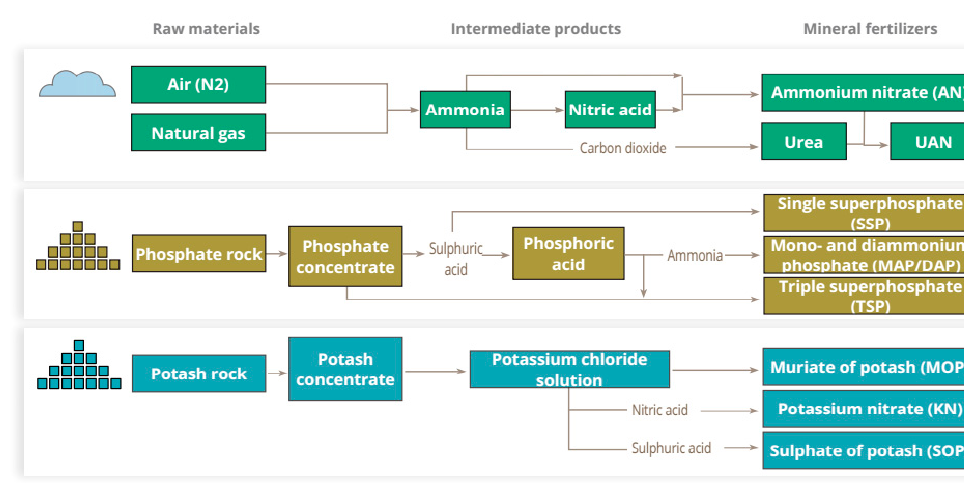
Figure 1. Production of main fertilizer [12]. Table 1. The overall energy use for urea production in fertilizer plants